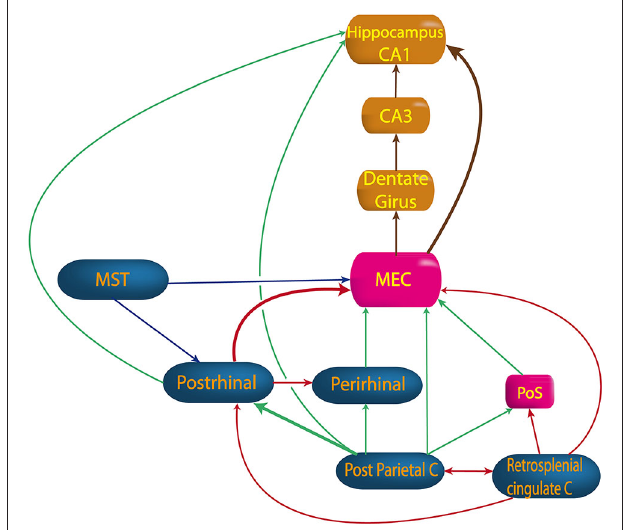
FIGURE 4 | Pathway from vestibular cortices to hippocampus . MEC, medial entorhinal cortex; MST, medial superior temporal cortex; Perirhinal, perirhinal cortex; PoS, posterior subiculum; Postrhinal, postrhinal cortex; Retrosplenial cingulate C, retrosplenial and cingulated cortices. (built from Burwell and Amaral, 1998; Rockland and Van Hoesen, 1999; Moser et al., 2008; Shinder and Taube,